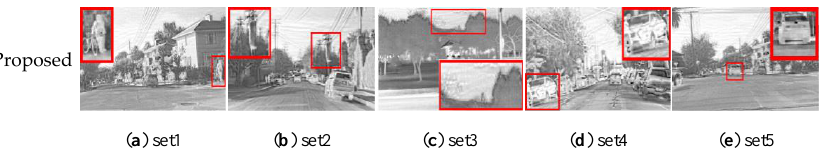
Figure 8. Results on the RoadScene dataset. From the first row to the last are IR images, VIS images, the fusion results of FPDE, VSM, Bala, Gauss, DRTV, LATLRR, SR, MDLatLRR, RFN, and the proposed method.